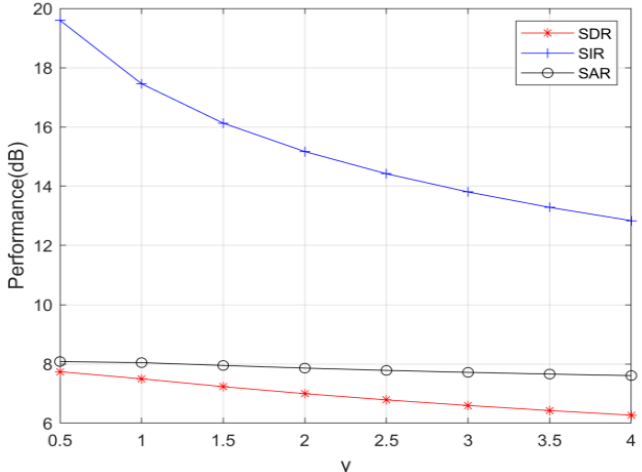
Figure 8. The separation performance with different γ .